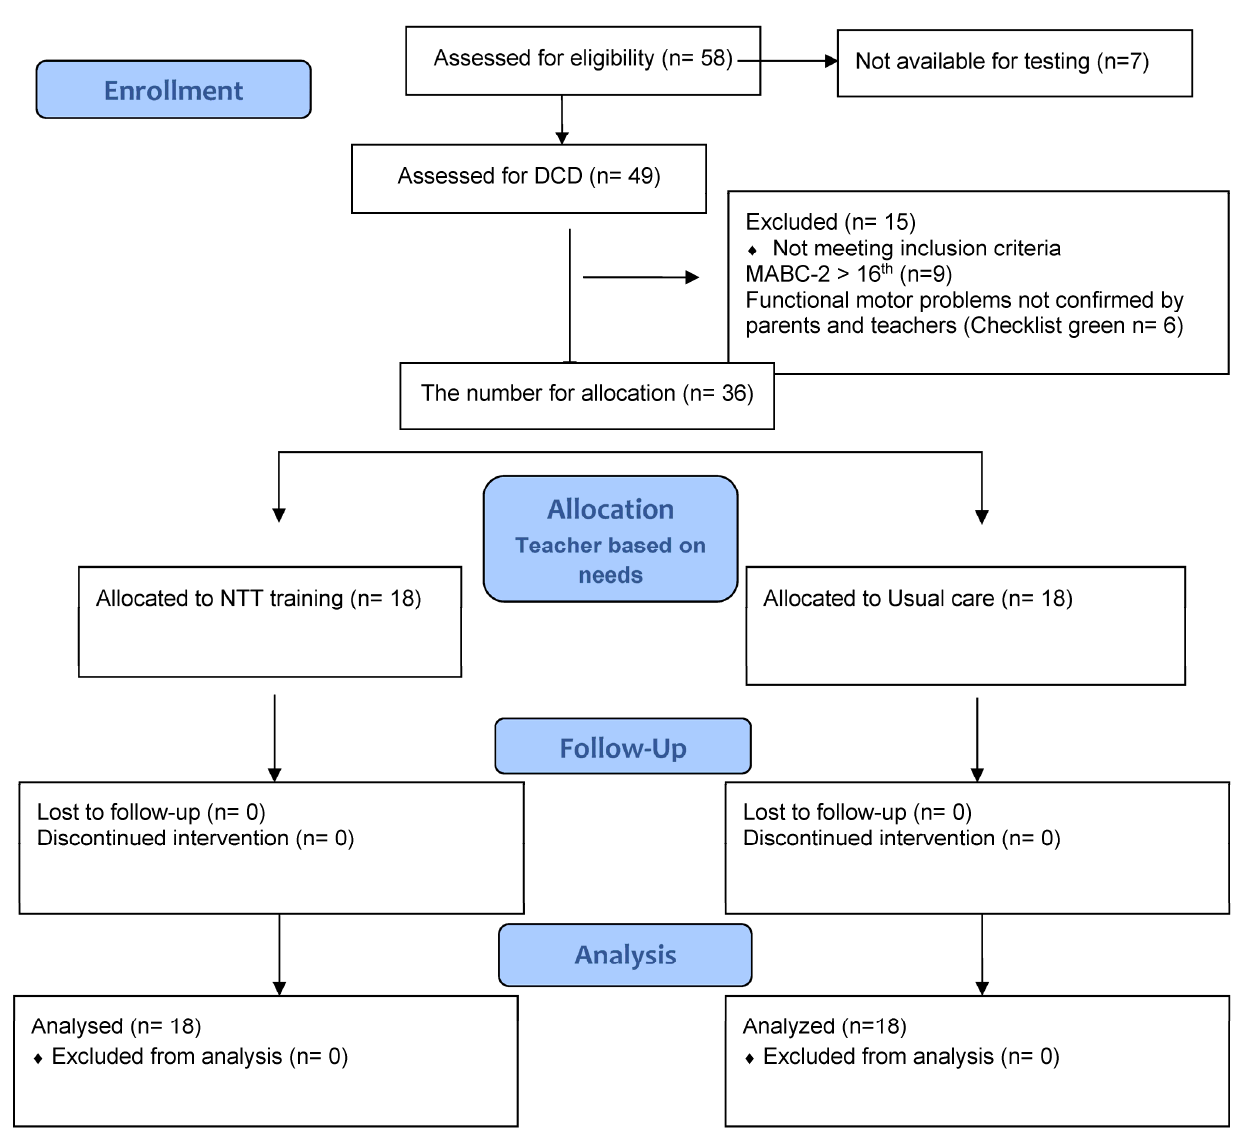
Figure 1. Flowchart of children’s recruitment process of the study.